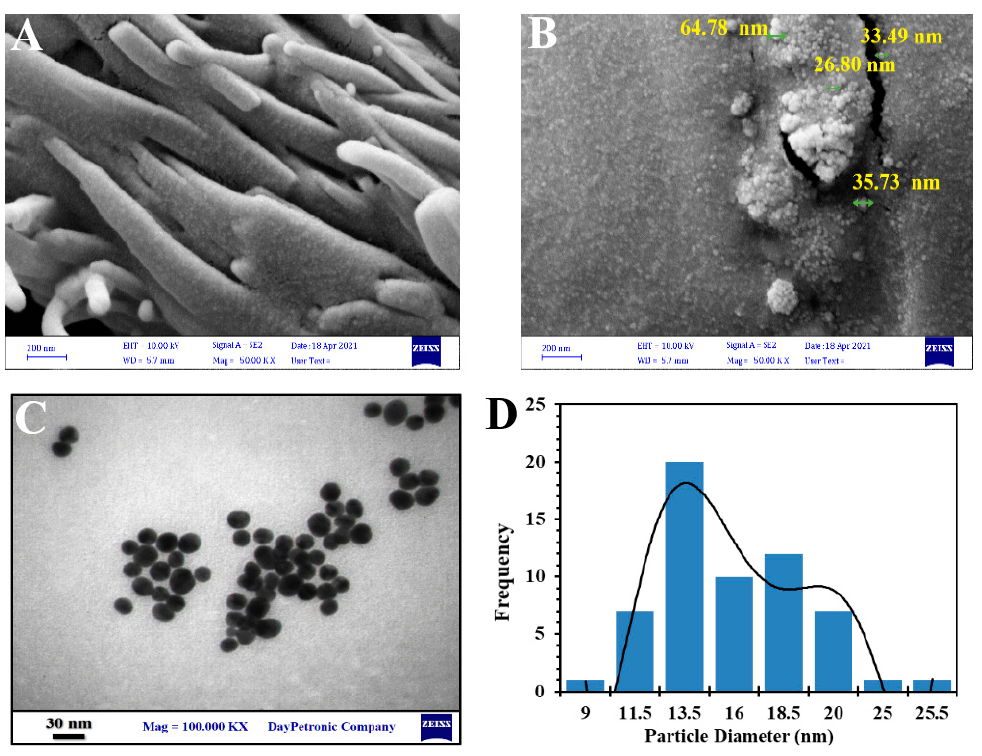
Figure 6. Image analysis of electron microscope (FESEM) of ( A ) pure galangin and ( B ) GAL/ β -CD, ( C ) transmission electron microscopy (TEM), and ( D ) particle size distribution.